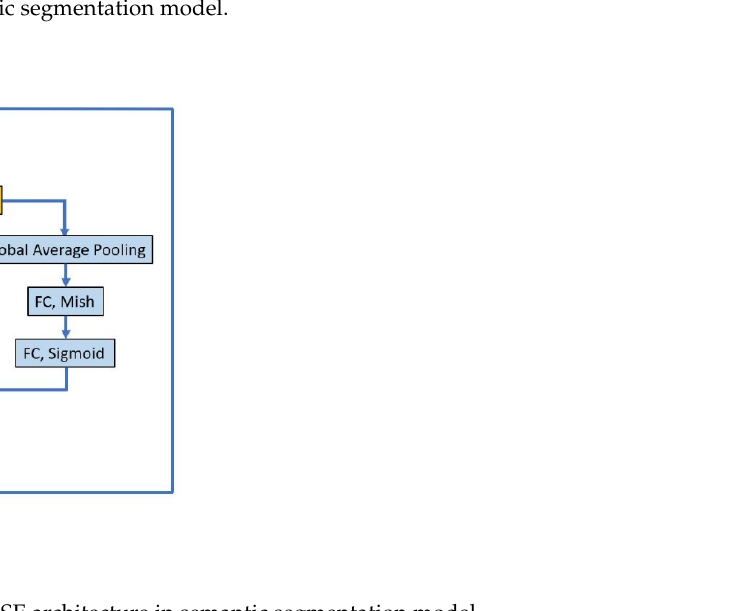
Figure 17. DWS + SE architecture in semantic segmentation model.